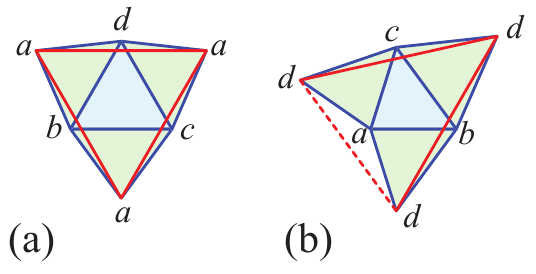
Figure 16. Two star unfoldings of a near-regular tetrahedron. In this example, ω a = 142 ◦ and ω b = ω c = ω d = 193 ◦ . Geodesic loops are solid red segments. In ( a ), each loop has angle 12 ◦ to one side of a and 206 ◦ to the other side. In ( b ), θ d = 167 ◦ , so the loops are quasigeodesics.